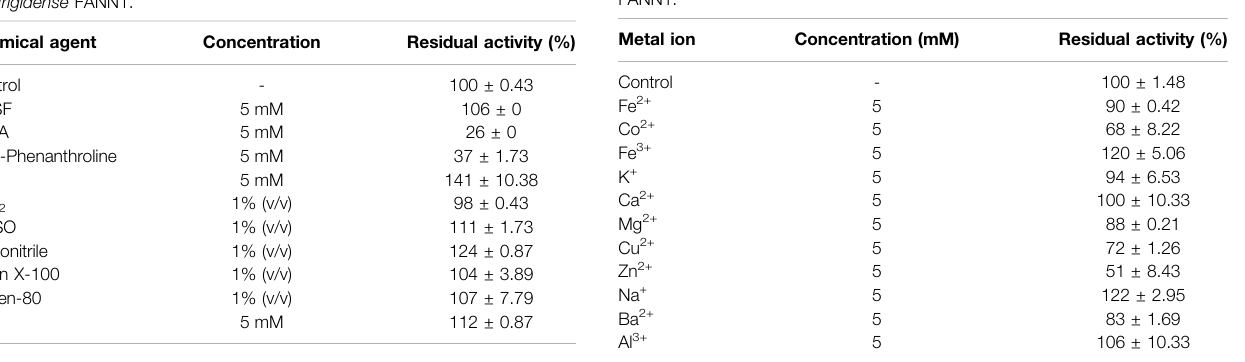
TABLE 3 | Effect of metal ions on the stability of keratinase from C. aquifrigidense